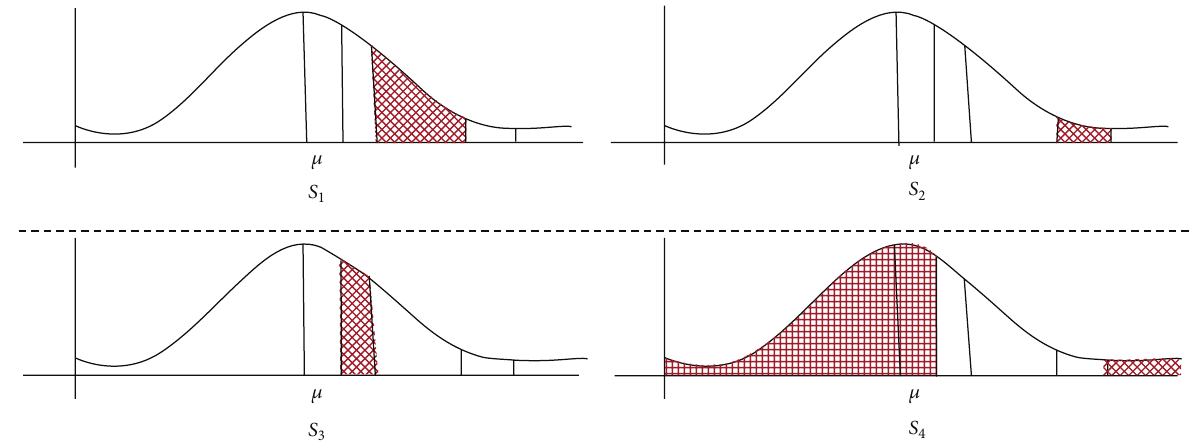
Figure 1: Graphical representations of 𝐻 0 and the alternative